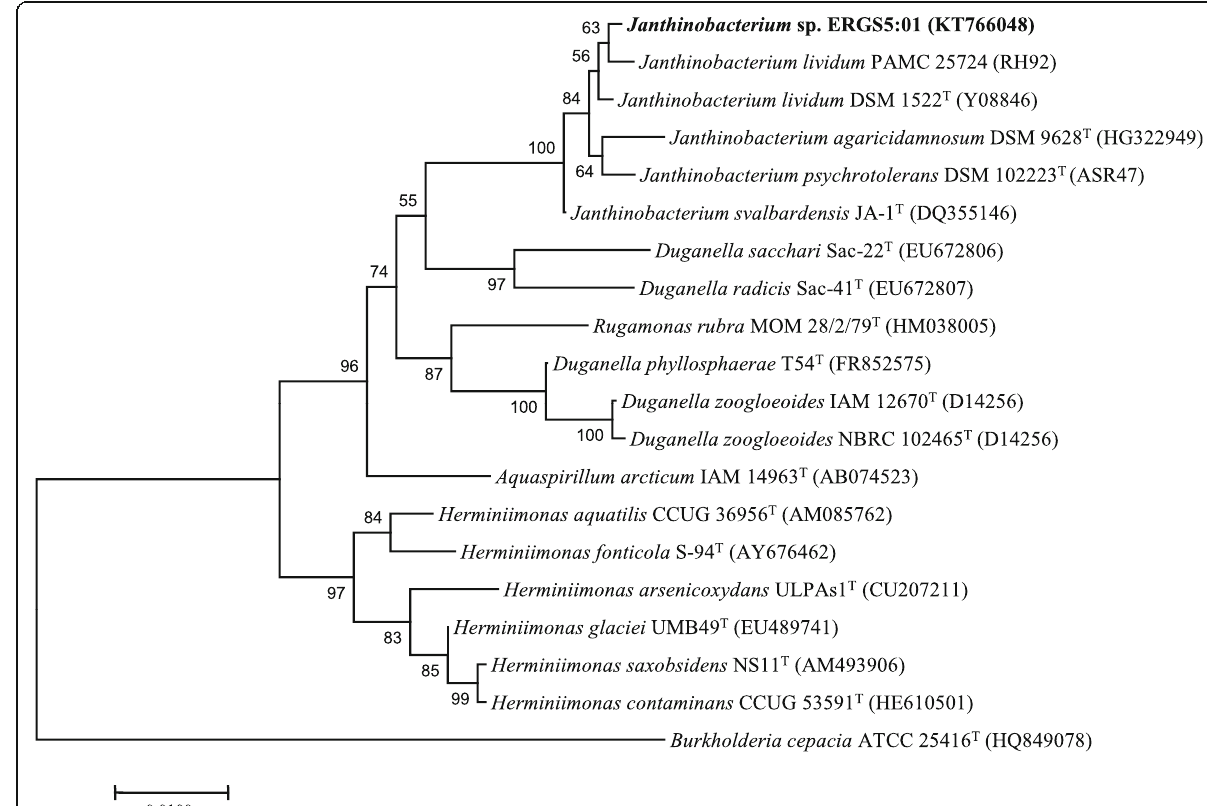
Fig. 2 Phylogenetic tree based on 16S rRNA gene sequences of strain J. lividum ERGS5:01and nearest validly published strains obtained from NCBI database [16] was created using MEGA version 7.0 [17]. The sequences were aligned using Clustal W and the Neighbor-Joining tree was created based on the Jukes-Cantor model with 1000 bootstrap replications. Strain ERGS5:01 forms cluster with J. lividum PAMC 25724 T . Burkholderia cepacia ATCC 25416 T was used as the out group organism and the scale bar corresponds to the expected number of changes per nucleotide position. NCBI accession numbers are given in